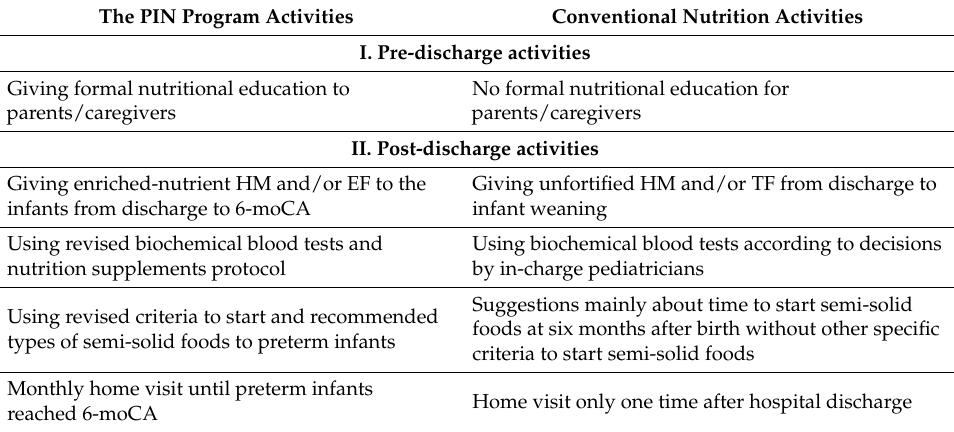
Table 1. Comparisons of activities in the preterm infant post-discharge nutrition (PIN) program and conventional nutrition